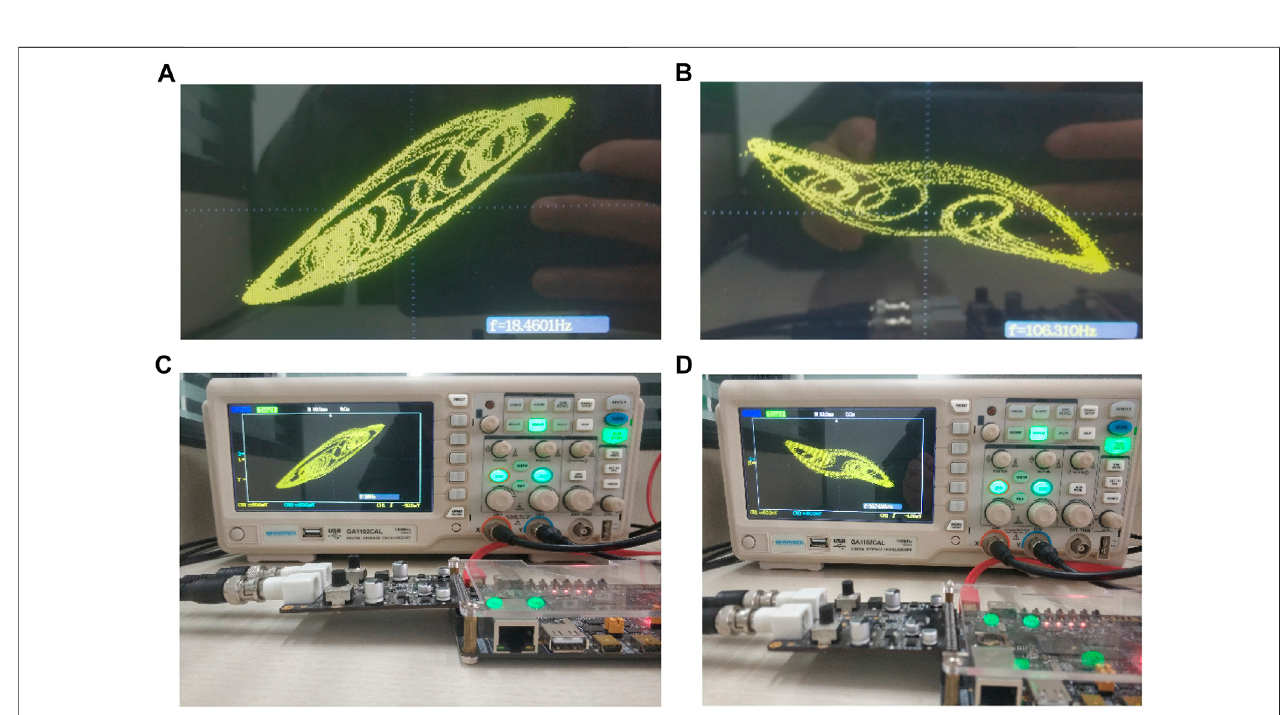
FIGURE7| Theoscilloscopeshowstheexperimental resultsof (A) FPGA-based x − w planephasediagram; (B) FPGA-based y − w planephasediagram; (C) and (D) indicate the experimental setup of (A) and (B) , respectively.